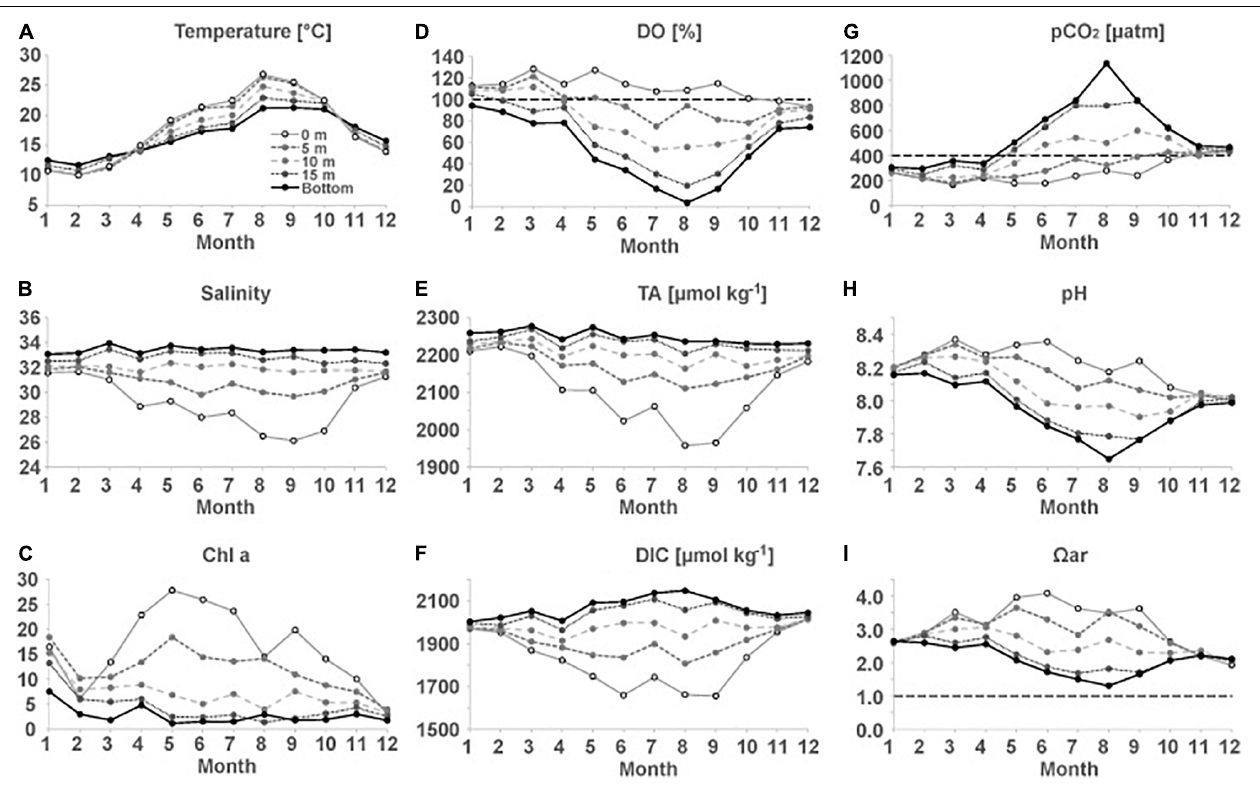
FIGURE 2 | Seasonal variations in (A) T, (B) S, (C) Chl a , (D) DO%, (E) TA, (F) DIC, (G) pCO 2 , (H) pH, and (I) (cid:127) ar at station F3. Black horizontal dashed lines in (D,G,I) indicate the O 2 saturation, CO 2 saturation (relative to mean atmospheric CO 2 for the observation period), and aragonite saturation ( (cid:127) ar = 1),